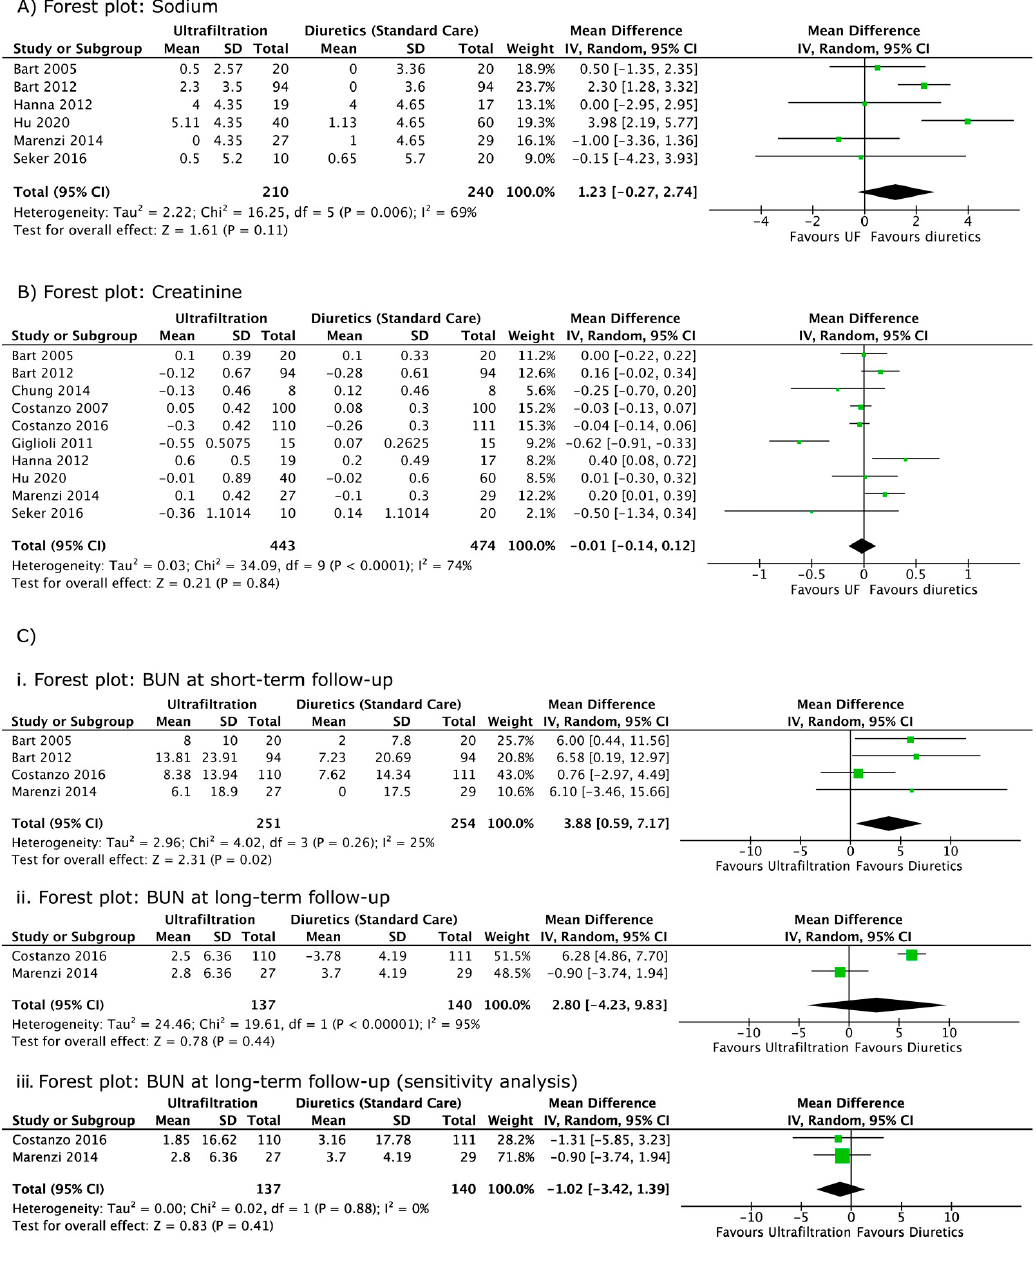
Figure 3. Forest plot of renal biomarkers (sodium, creatinine and BUN). ( A ) Forest plot demonstrating the mean difference in sodium (change from baseline) between ultrafiltration and diuretic groups. ( B ) Forest plot comparing the mean difference in creatinine (change from baseline) between ultrafiltration and diuretic groups. ( C ) ( i ) Forest plot comparing mean difference in short-term BUN (only includes data reported before or at discharge) between ultrafiltration and diuretic groups. ( ii ) Forest plot comparing the mean difference in long-term BUN (only includes data reported after discharge) between ultrafiltration and diuretic groups. Heterogeneity demonstrated by the I 2 test is 95%. ( iii ) Forest plot demonstrates the impact of a sensitivity analysis (using data reported by Cos- tanzo, 2016 at 2 instead of 3 month) on mean differences in long-term BUN. Standard deviations for Marenzi, 2014 at 12 months were imputed from Costanzo, 2016 at 3 month. Individual studies are represented by their author and year of publication in the first table column. Mean differences and 95% confidence intervals are presented for individual studies. IV, inverse variance; CI, confidence interval [3–7,10,16,17,21,22].